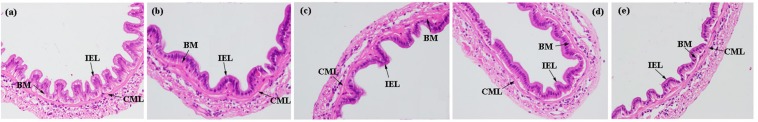
Histological analysis of intestine from of shrimp fed diets with 0 (a), 25% (b), 50% (c), 75% (d), and 100% (e) replacement of fishmeal by fish silage (FS). BM, basement membrane; CMLs, circular muscle layers; IEL, intestinal epithelial layer. Stained with hematoxylin and eosin (H&E), 200×.